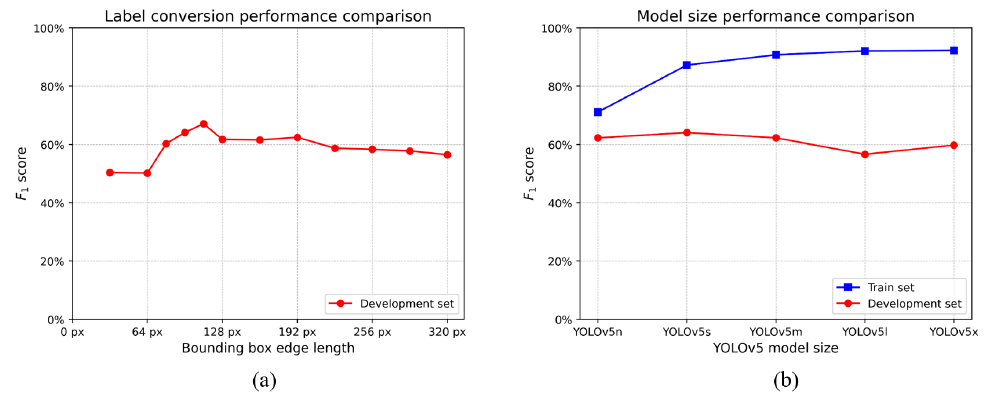
Figure 3. Results of the experiments. ( a ) F 1 scores of YOLOv5s across different bounding box edge lengths in pixels. ( b ) F 1 scores on the training set and the development set across multiple YOLOv5 model sizes.